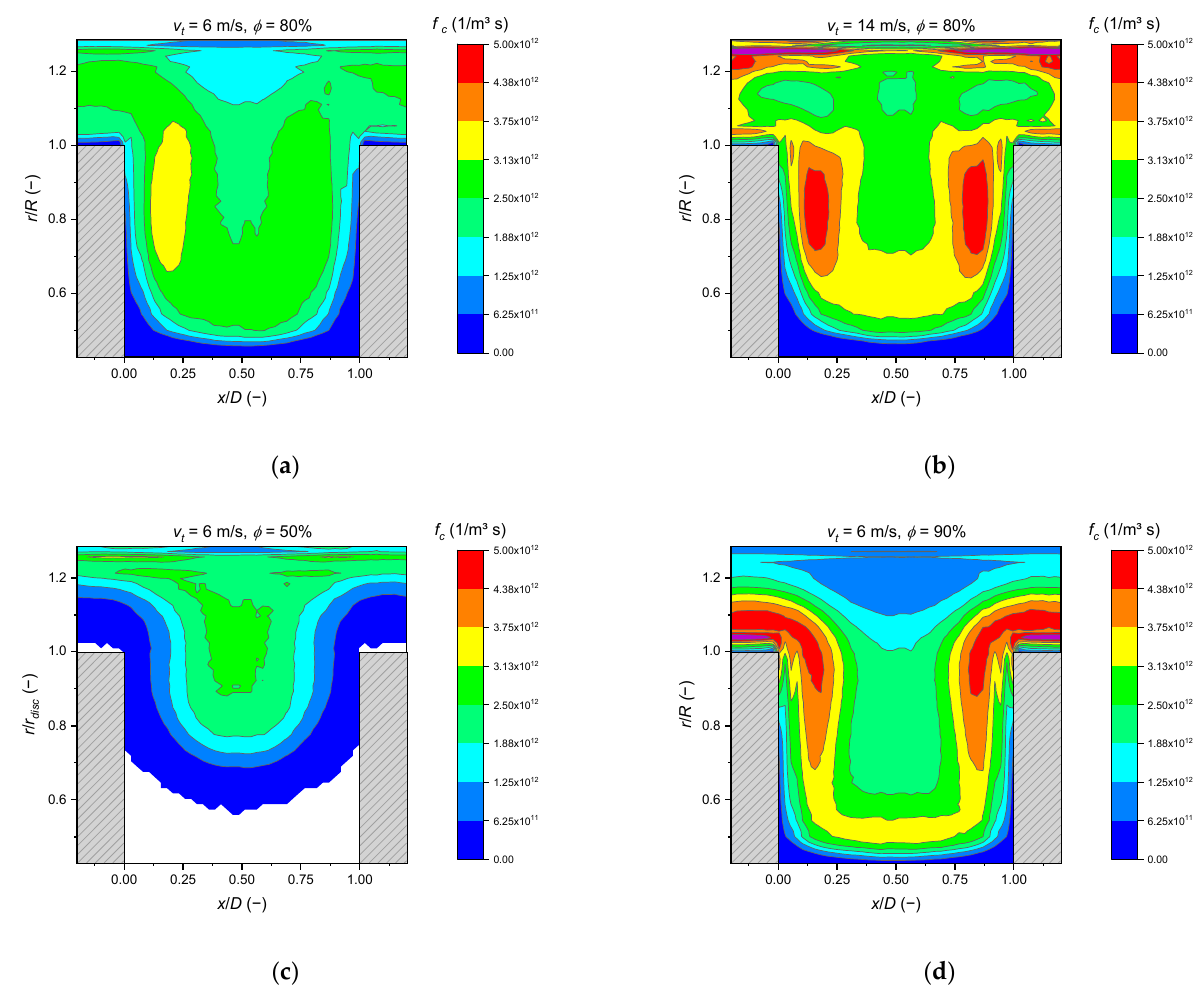
Figure 13. Radially averaged local collision frequency f c on a linear color scale: ( a ) stirrer tip speed of 6 m/s and grinding media filling of 80%; ( b ) stirrer tip speed of 14 m/s and grinding media filling of 80%; ( c ) stirrer tip speed of 6 m/s and grinding media filling of 90%; ( d ) stirrer tip speed of 6 m/s and grinding media filling of 50%.